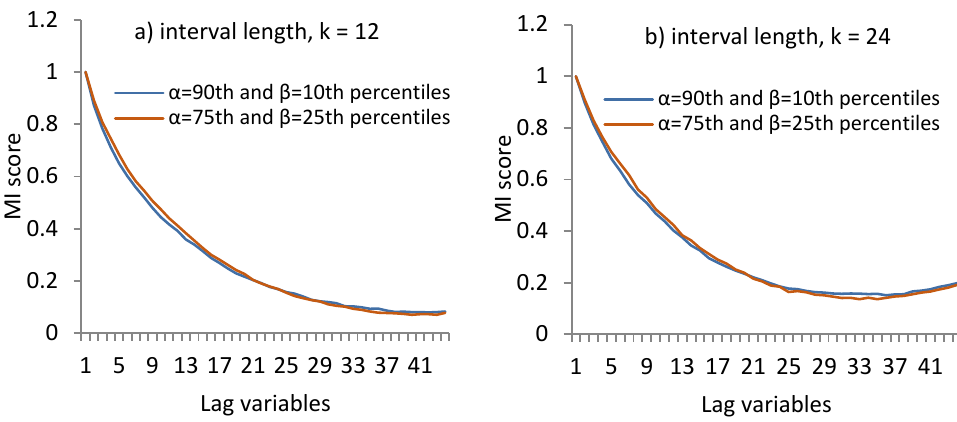
Figure 4. MI score of lag variables for intervals with different length k : ( a ) k = 12 and ( b ) k = 24.